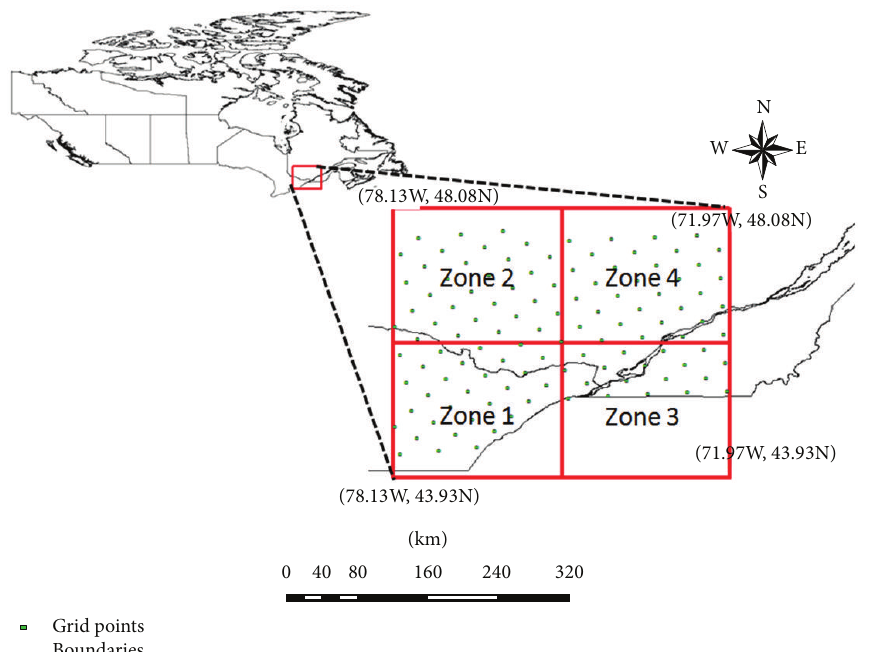
Figure 1: Study area over Qu´ebec and Ontario Provinces,